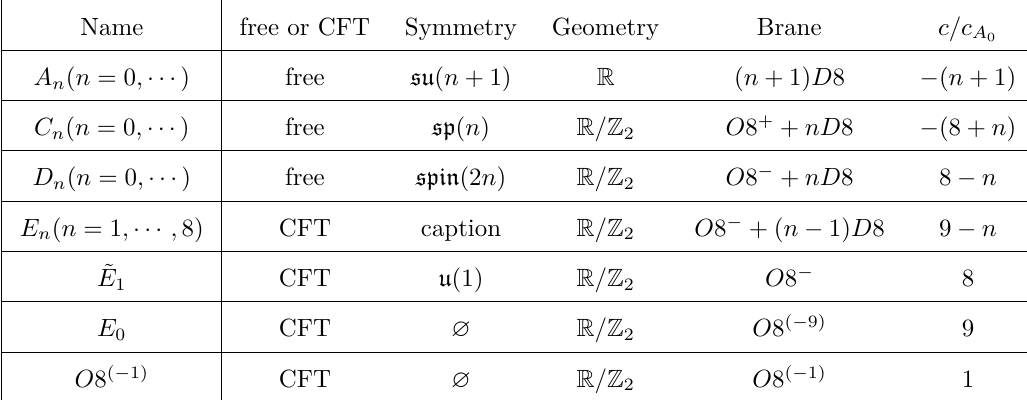
Table 1 . List of 4-brane worldvolume theories with one-dimensional Coulomb branch. Global symmetries of E n and ˜ E 1 theories are E 8 = e 8 , E 7 = e 7 , E 6 = e 6 , E 5 = spin (10) , E 4 = su (5) , E 3 = su (3) + su (2) , E 2 = su (2) + u (1) , E 1 = su (2) , ˜ E 1 = u (1) , E 0 = ? . The Higgs branch is given by one-instanton moduli space (two-instantons moduli space for C n ). The geometry column refers to the local geometry around the symmetry enhanced point. See eqs. (3.8) and (3.9) for the details of the c/c A column, and the text after (3.13) for details behind the brane 0